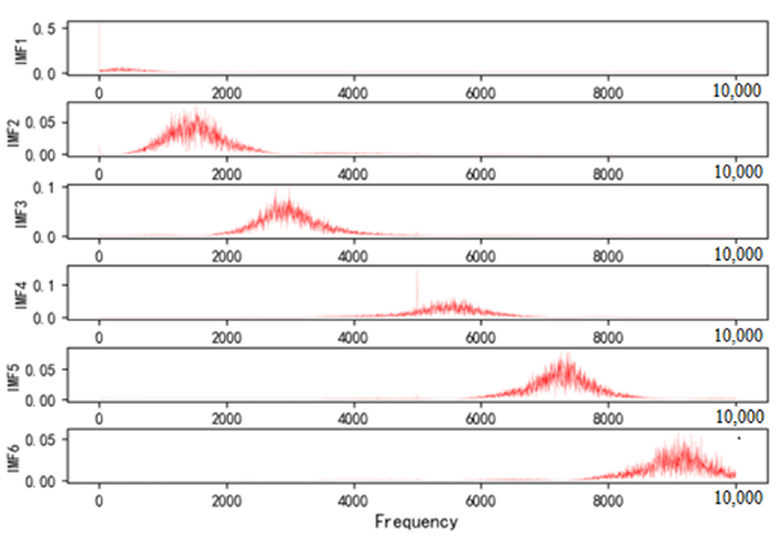
Figure 6. Frequency spectrum of each IMF.